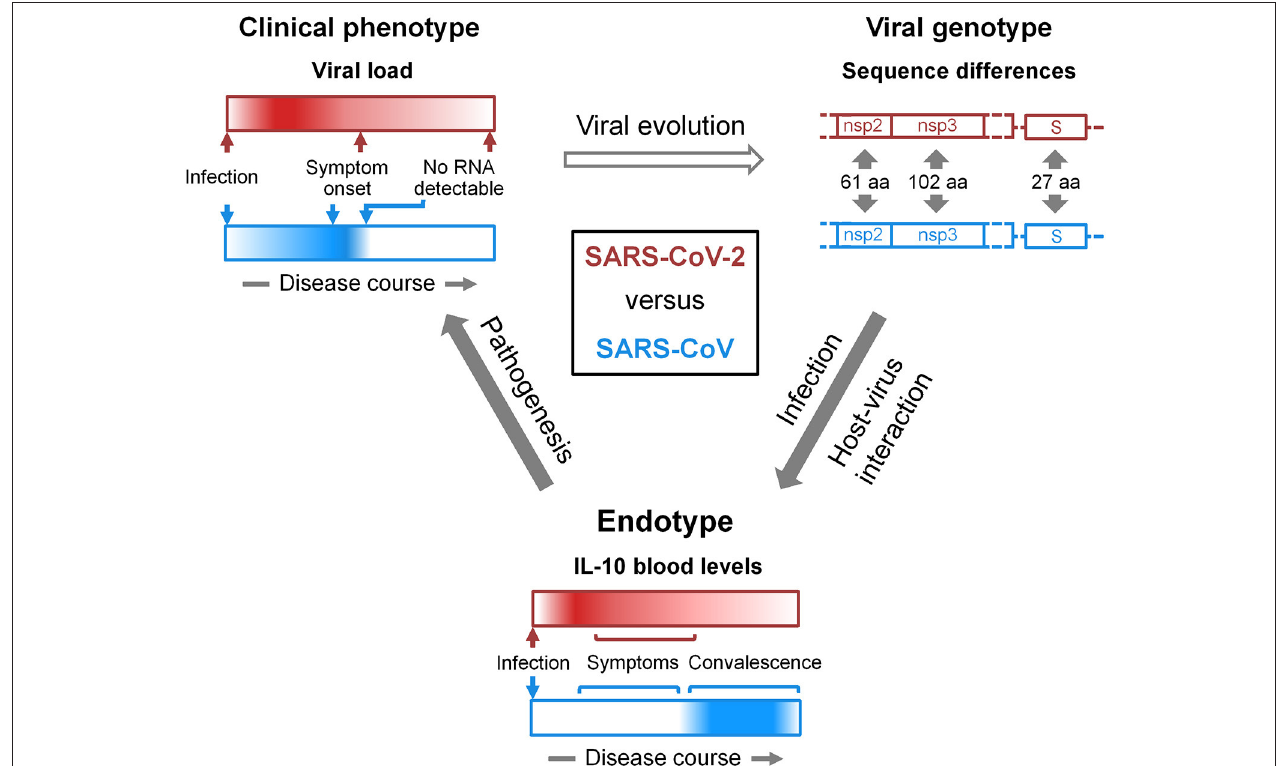
FIGURE 1 | Viral genotype-endotype-clinical phenotype relationships in COVID-19 and SARS. At the bottom , the dynamics of the IL-10 response to SARS-CoV-2 (red) and SARS-CoV (blue) infections is schematized as horizontal bars. Dark color and white represent high and low levels, respectively, of IL-10 in peripheral blood (section IL-10 in COVID-19). In severe COVID-19 but not in SARS, IL-10 was found increased already in the first week of symptoms ( 9). Data on the levels of blood IL-10 in relation to the resolution of symptoms and in COVID-19-convalsecent blood has not yet been reported explicitly, but they appear to slowly decline with symptoms over the course of 2–3 weeks. We refer to IL-10 dynamics as endotype . In light of the lung protective properties of IL-10 and its role in microbial persistence (section Ambiguous Role of IL-10 in Lung Injury and Infection), we propose that the difference in this endotype contributes to the different viral load kinetics in COVID-19 and SARS (section SARS-CoV-2 Transmission vs. Clearance). Viral load kinetics are schematized at the top left in an analogous manner to the endotype and are referred to as clinical phenotype . The open arrow connecting clinical phenotype and viral genotype considers viral evolution in general inclusive of species jumping. The genotype schematic at the top right focuses on specific genome regions of the two viruses with sequence differences that give rise to the indicated numbers of amino acid (aa) changes in non-structural proteins 2 and 3 (nsp2, nsp3) and the spike (S) protein (section Discussion). One or a combination of such variations is likely responsible for the differential IL-10 response. However, a functional role of silent mutations cannot be excluded. It also has to be noted, that the annotation of open reading frames in the SARS-CoV-2 genome appears not yet complete, and new polypeptide products are being discovered (126). This type of diagram can be adapted in a flexible manner. For instance, it can be used to represent a variety of differences in viral genotypes , i.e., phylogenetic diversity, and putatively related endo- and phenotypes including those that may emerge during SARS-CoV-2 pandemic (127–130). Instead of the viral genotype , host genetic risk factors of COVID-19 (131–134) and their endotype and phenotype relations can be illustrated. Accordingly, endotypes can consist, for instance, in various immune evasion strategies and clinical phenotypes in any patient outcome. Moreover, external factors that influence evolution (top arrow), infection (right arrow), and pathogenesis (left arrow) can be incorporated, such as environmental